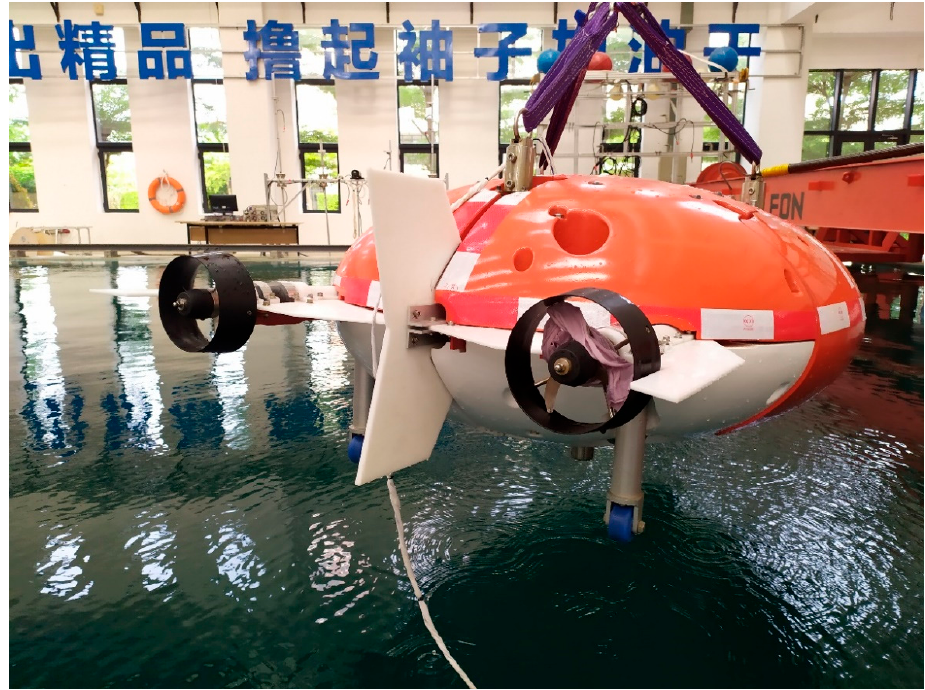
Figure 14. Thruster of the saucer-shape AUV entangled with cloth strips in the pool test.